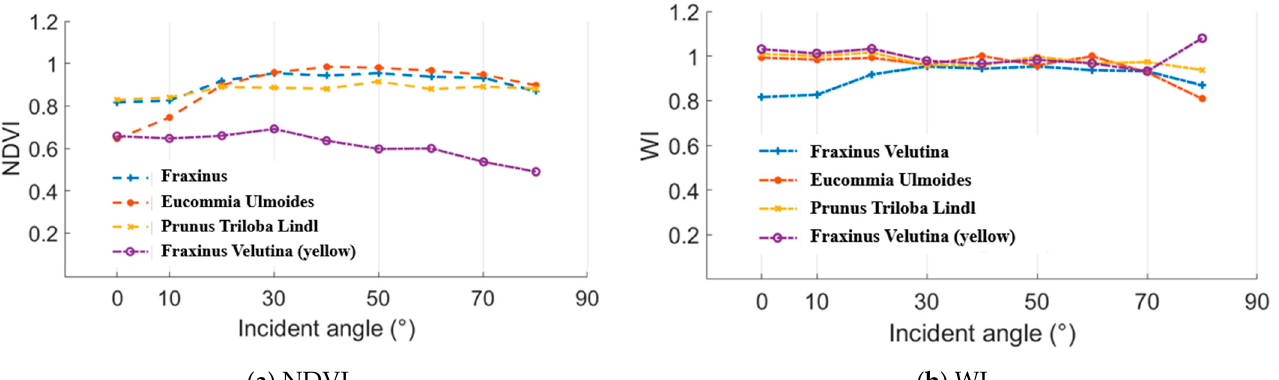
Figure 15. NDVI and WI results.